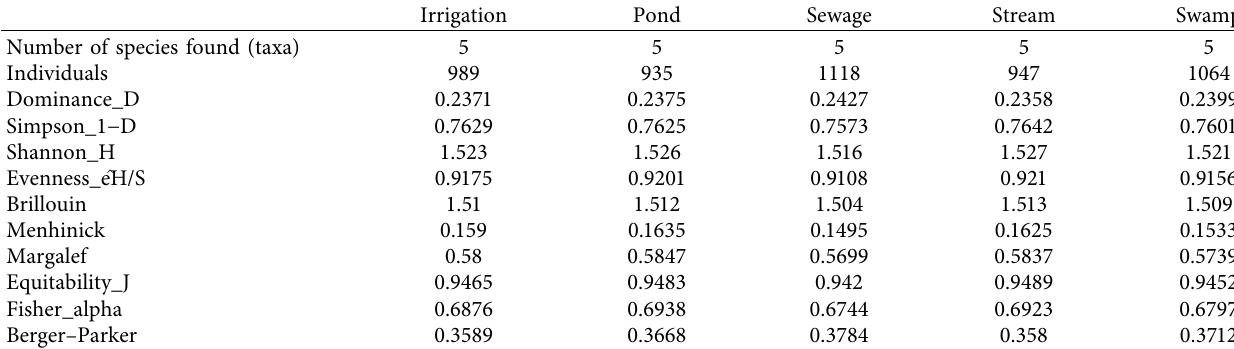
Table 3: Diversity indices of Anopheles mosquito larvae in different habitats.